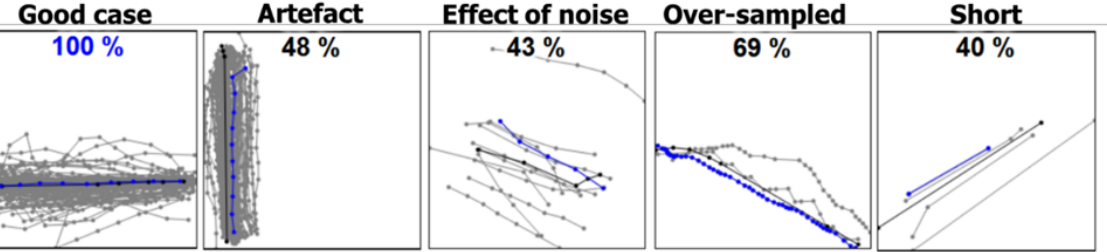
Figure 9. Examples of sets of k trajectories (gray lines) averaged by medoid with DTW distance (blue line). Black line is the ground truth.